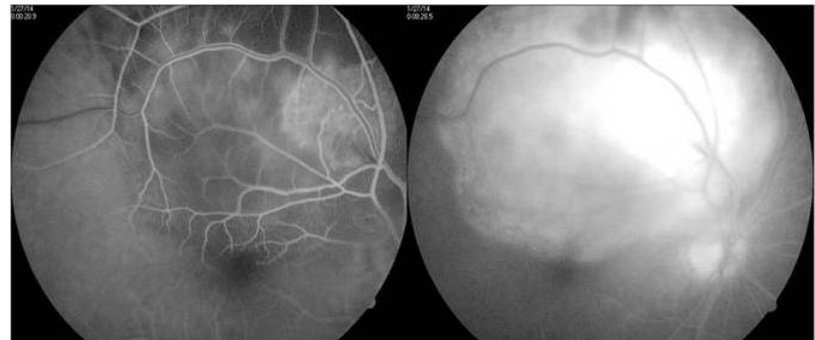
Figure 2: FFA shows early hyperflourescence with late pooling in serous detachment.